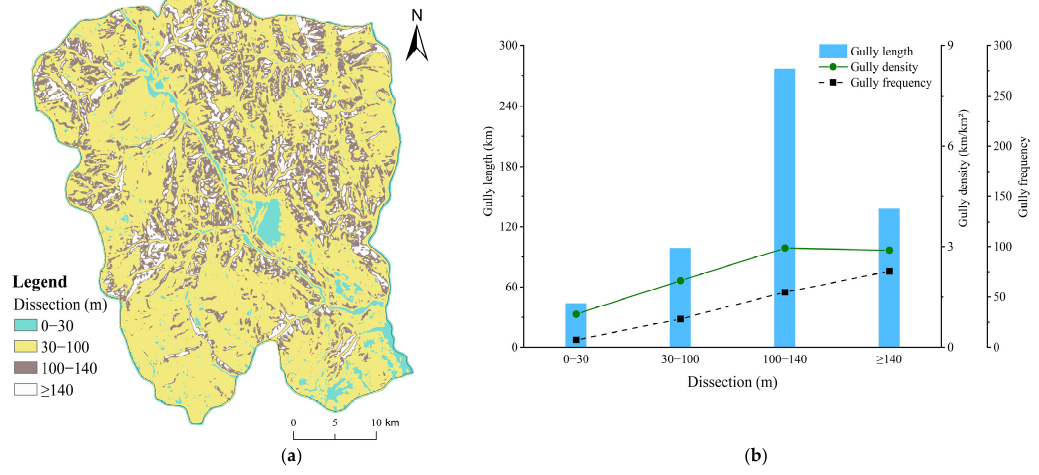
Figure 8. ( a ) Distribution of reclassified dissection ranges; ( b ) Characteristics of gully system pa- rameters (gully length, density, and frequency) under different dissection ranges.